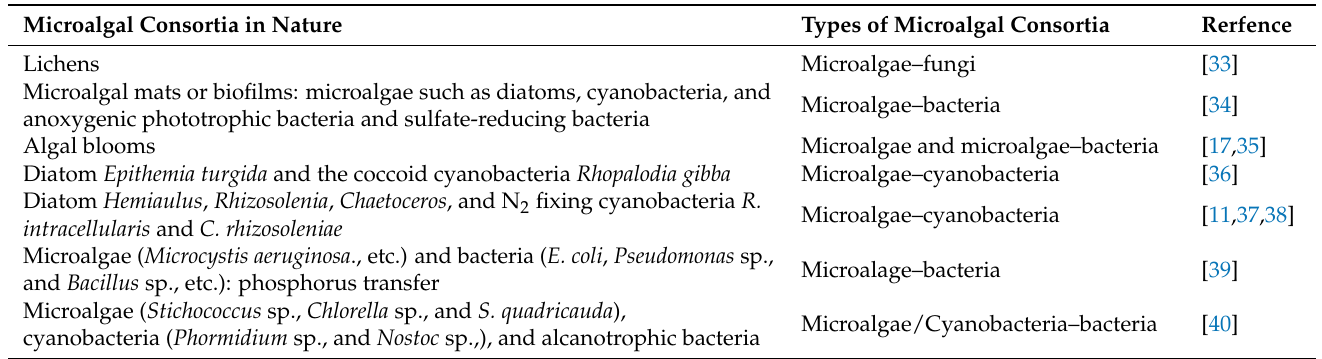
Table 1. Some examples of microalgal consortia in